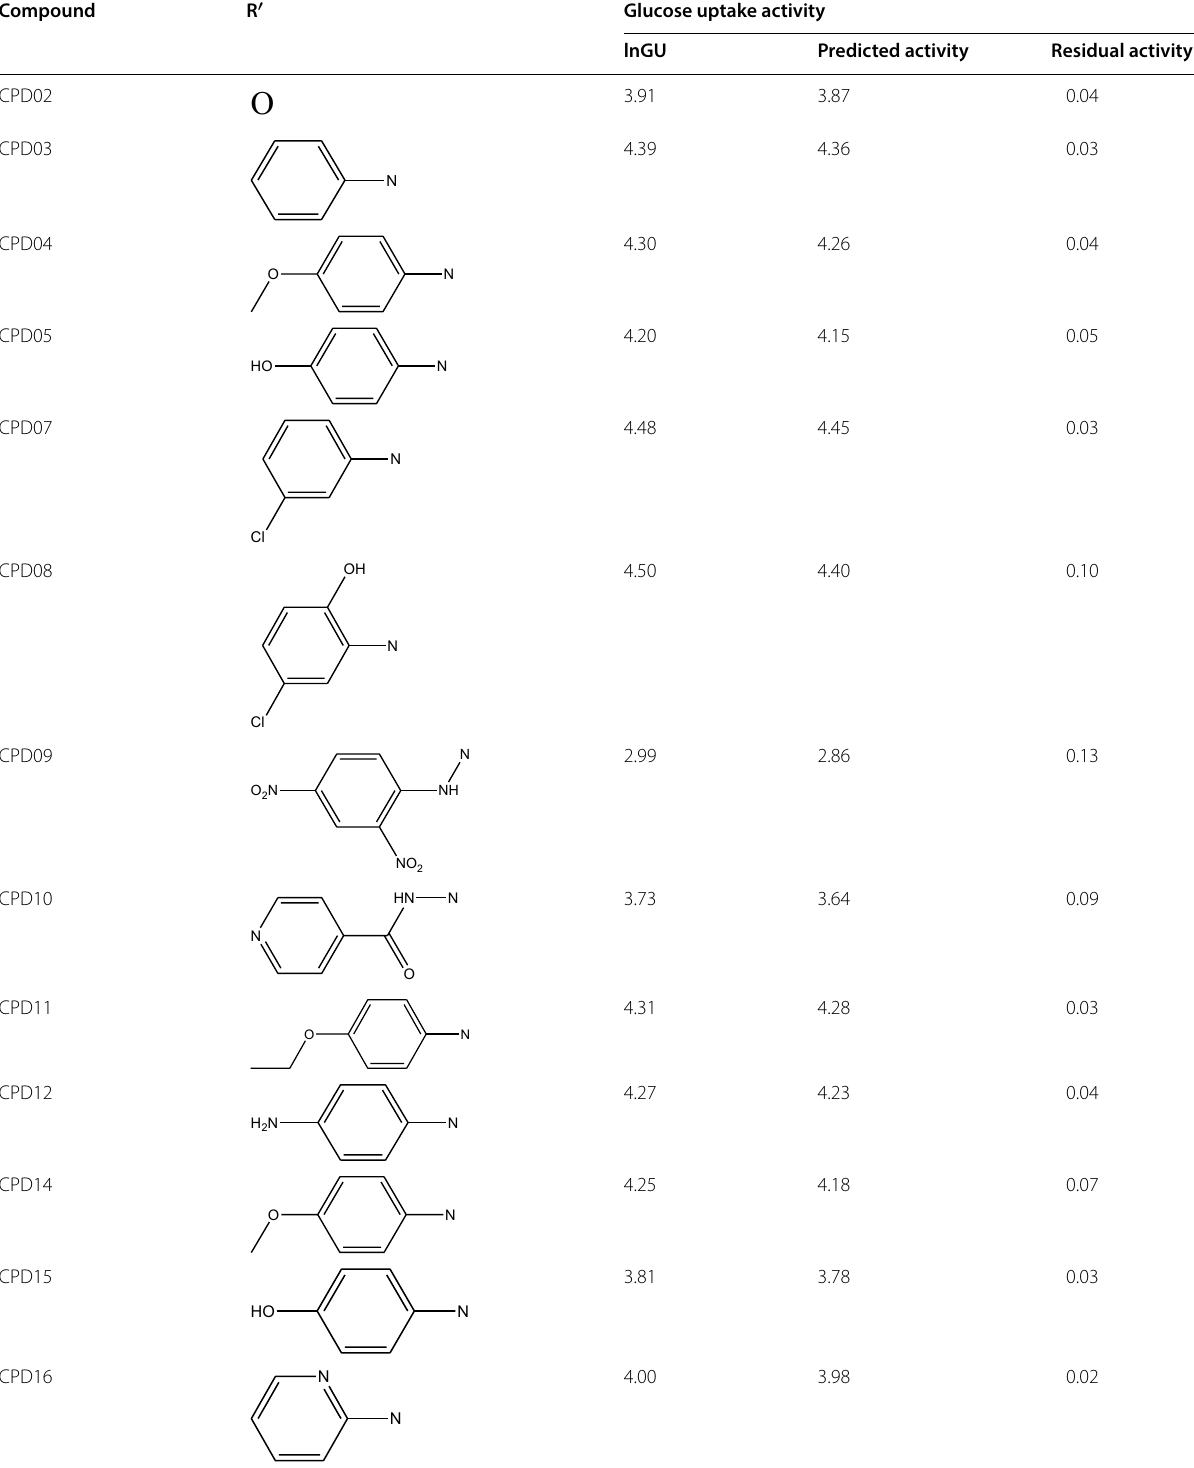
Table 7 Compounds considered for the training set Compound